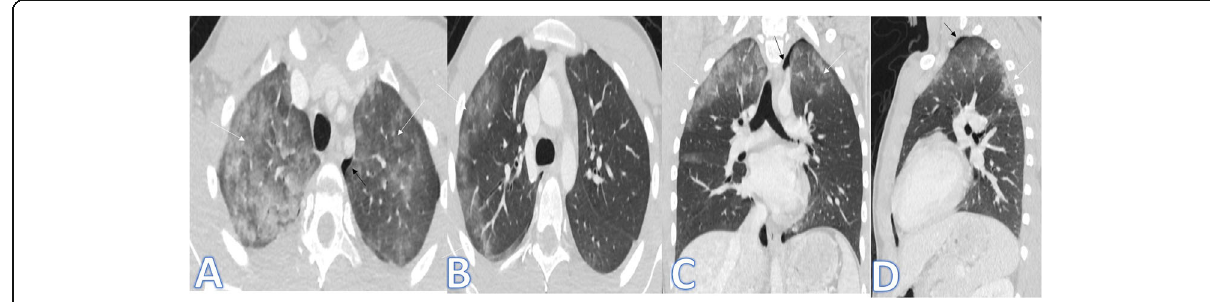
Fig. 5 A 19-year-old male patient presented with chest tightness after trauma. He had a history of trauma 1 day ago. CT chest showed bilateral GGO at both the upper lobes and right lower lobes with peripheral predilection (white arrows), the thin rim of the left pneumothorax (black arrow) was seen on the left side, and the diagnosis was post-traumatic pulmonary